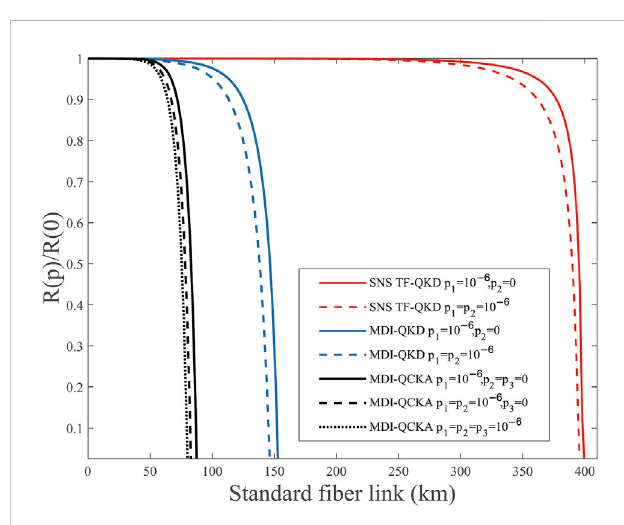
FIGURE 5 (Color online) R ( p )/ R (0) vs. transmission distance with p 1 , p 2 , p 3 = 0, 10 − 6 and N = 10 14 . The red lines are the results of SNS TF-QKD, the blue lines are the results of MDI-QKD, and the black lines are the results of